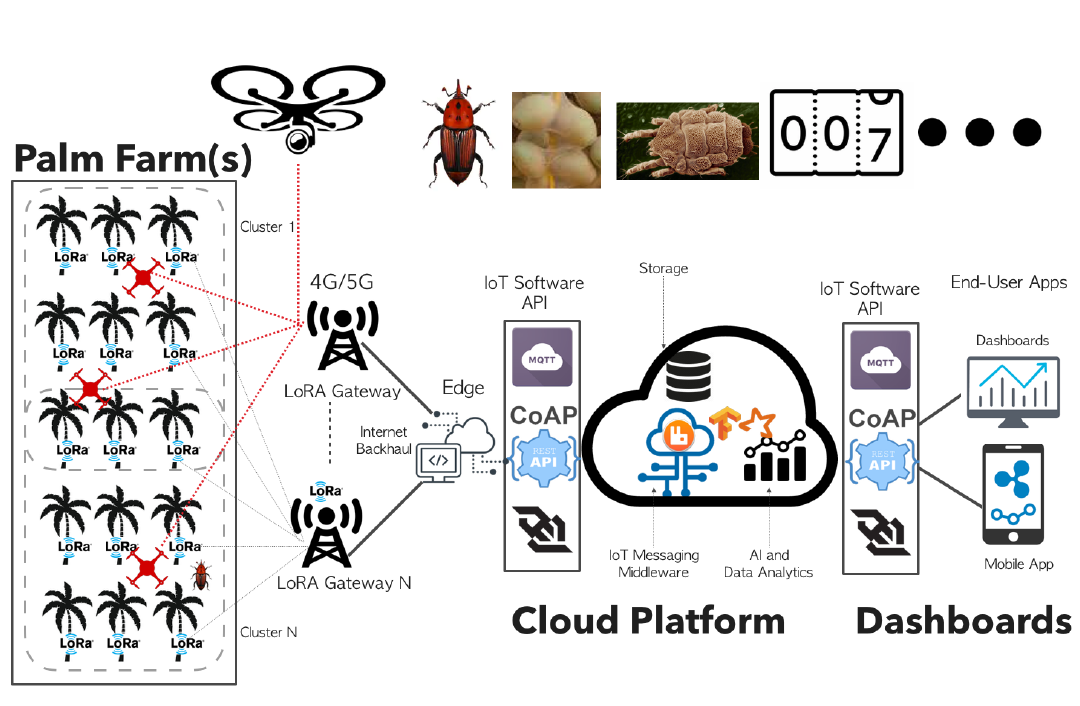
Figure 1. Smart Palm